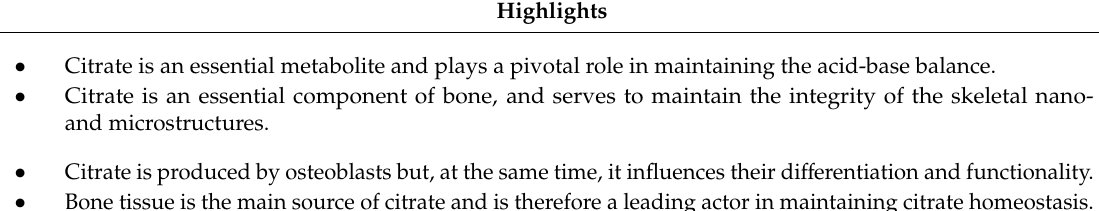
Table 4. The role of citrate in the pathophysiology and medical management of bone diseases.